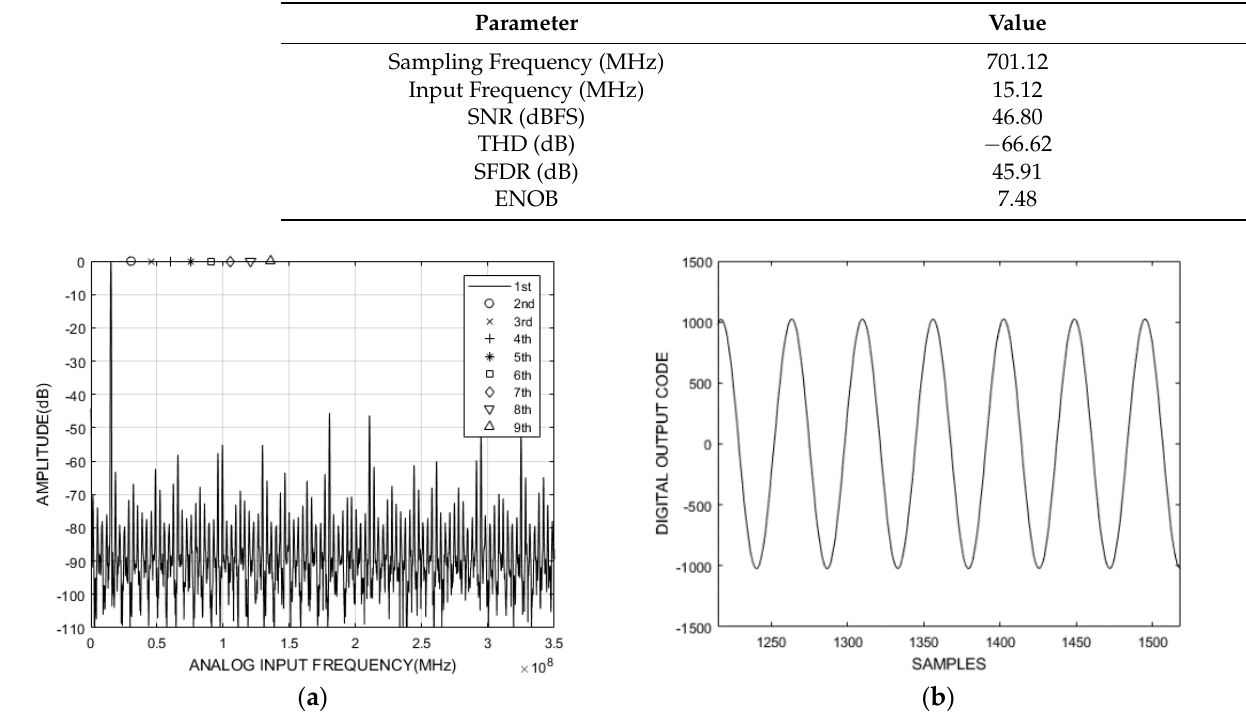
Figure 6. ( a ) Spectrum of un-interpolated resampling results; ( b ) Time domain waveform recovered without interpolation resampling.